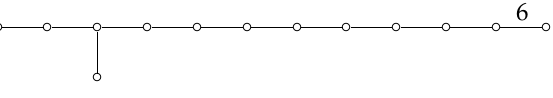
Figure 9. The Coxeter pyramid group Γ 11 ⊂ Isom H 11